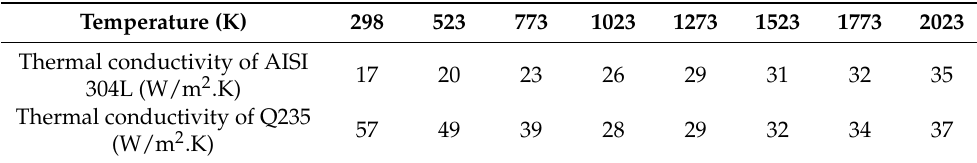
Table 4. The thermal conductivity of AISI 304L and Q235 steel.